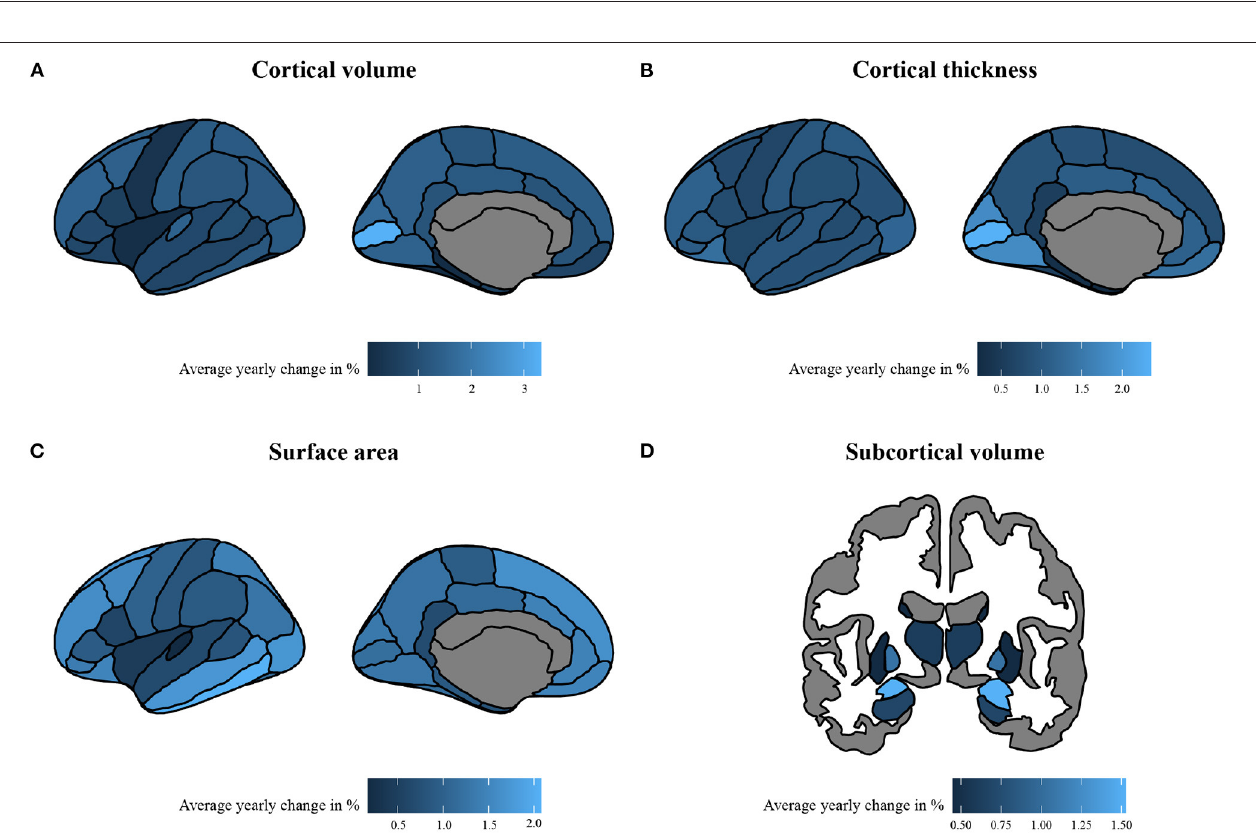
FIGURE 3 | Examples of patterns of cortical thickness for each subject in the first fold and the fit of the normative model to the cortical thickness in the training set. A wider prediction range outside of data distribution is used for visualization purposes. For illustrative purposes, measures are rescaled to the original means and standard deviations.